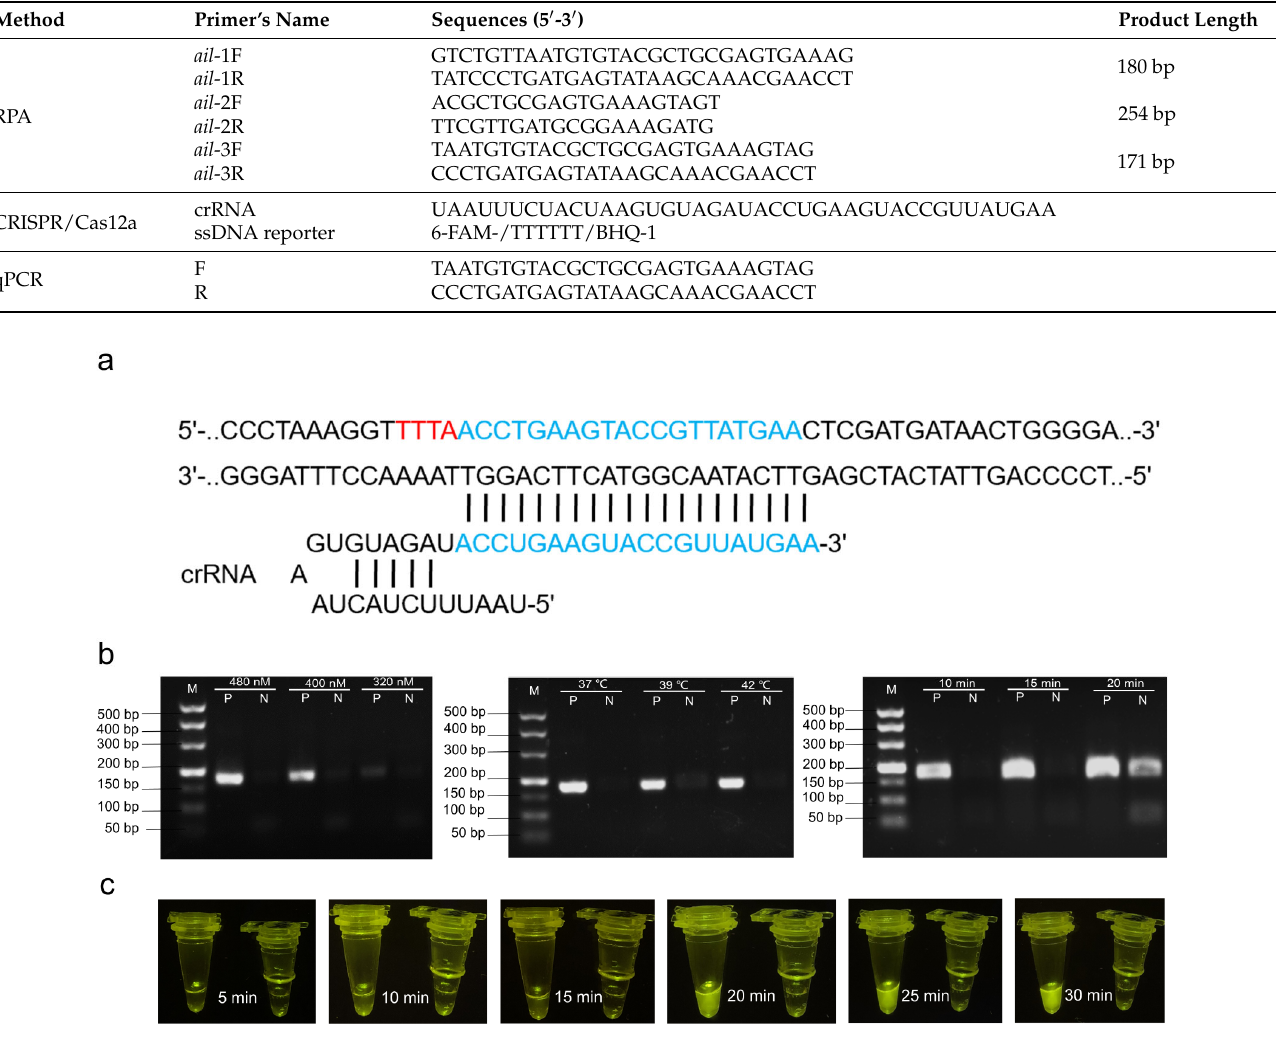
Figure 2. Optimization of the CRISPR/Cas12a ‐ RPA system: ( a ) sequences of targets and crRNA de ‐ signs used for the detection of pathogenic Y. enterocolitica ; ( b ) optimization of RPA primer concen ‐ tration, temperature, and reaction time (lanes N and P are negative and positive samples amplified by RPA under the different conditions; M is 500 bp marker); ( c ) visualization of the results at differ ‐ ent time